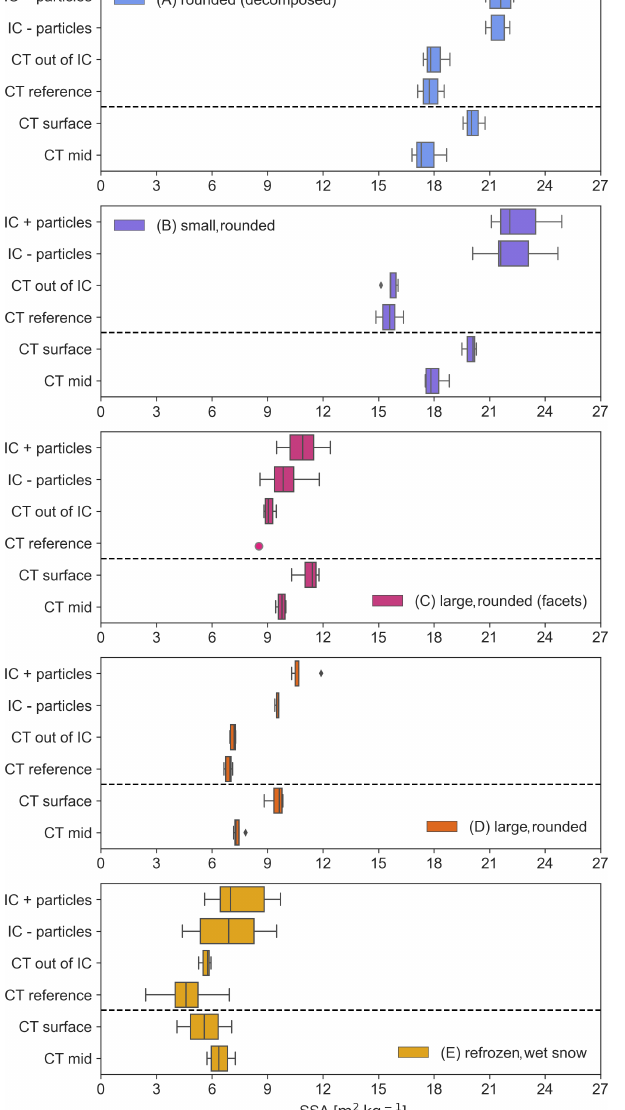
100 % marks the pure substrate SSA for each snow type. The SSA measured at a wavelength of 1310 nm is much more sus- ceptible to the influence of a layer with loose particles. The changes are most prominent for snow types D and E. The slope is about 4 times higher at a wavelength of 1310 nm than at 950